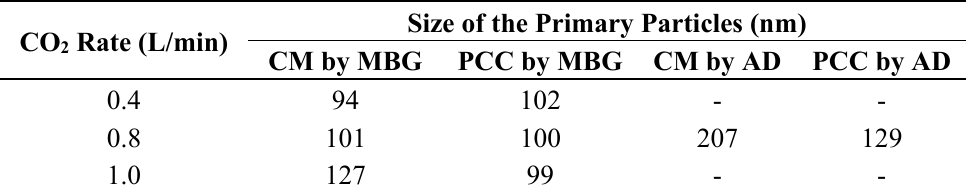
Figure 5. SEM images of CaCO 3 produced by AD and MBG using gypsum and Ca(OH) 2 : ( a ) gypsum by MBG; ( b ) Ca(OH) 2 by MBG; ( c ) gypsum by AD and ( d ) Ca(OH) 2 by AD. The particles in this panel were obtained CO 2 flow at 0.8 L/min, with AD and MBG. Table 2. Calculated size of the primary particles based on specific surface